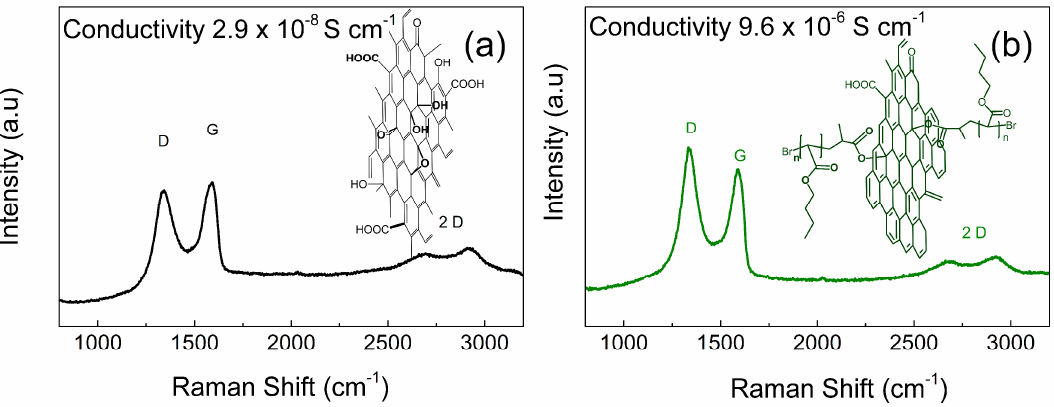
Figure 5. Raman spectra and electrical conductivities for neat GO ( a ) and GO-PBA ( b ) particles.